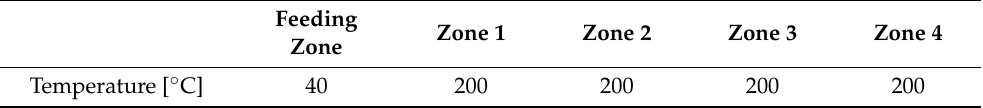
Table 3. Process temperatures of injection molding.